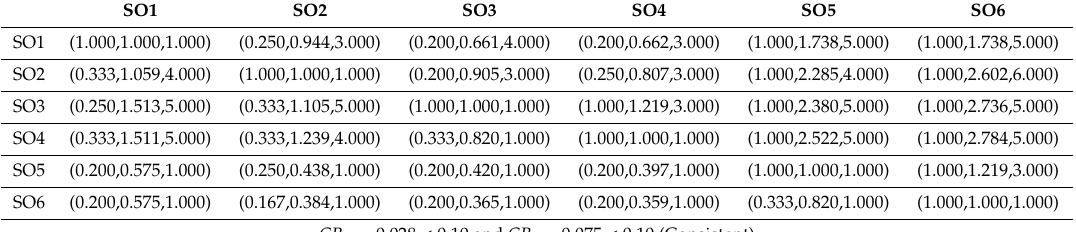
Table A8. Fuzzy pairwise comparison matrix with respect to the social (SO) sub-criteria.